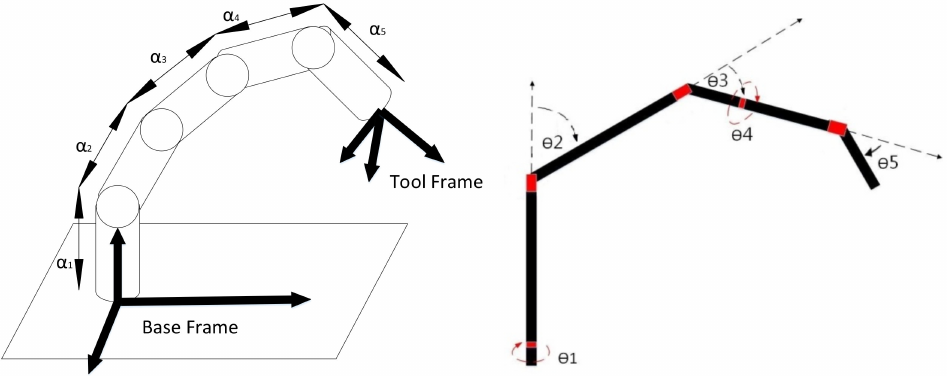
Figure 2. Kinematic model of a robotic arm with five degrees of